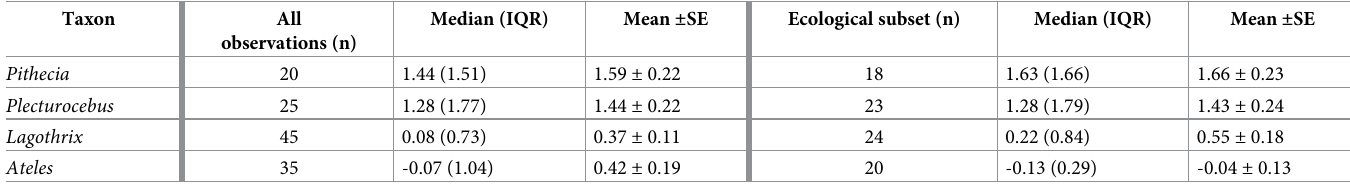
Left columns: Number of observations, medians, and means for the the total sample. Right columns: Medians and means for the subset of observations that included data for all three ecological variables—temperature, rainfall, and ripe fruit